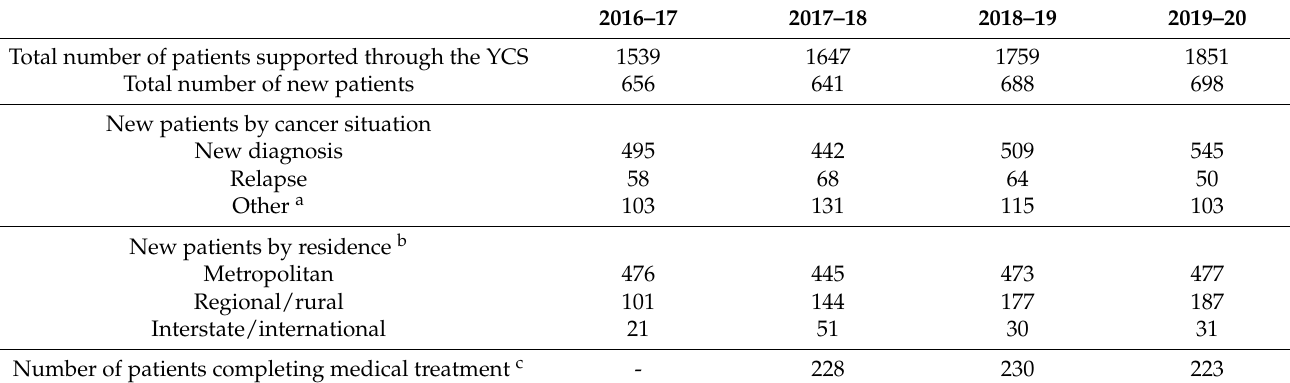
Table 1. Numbers of patients supported through the YCS, 2016–17 to